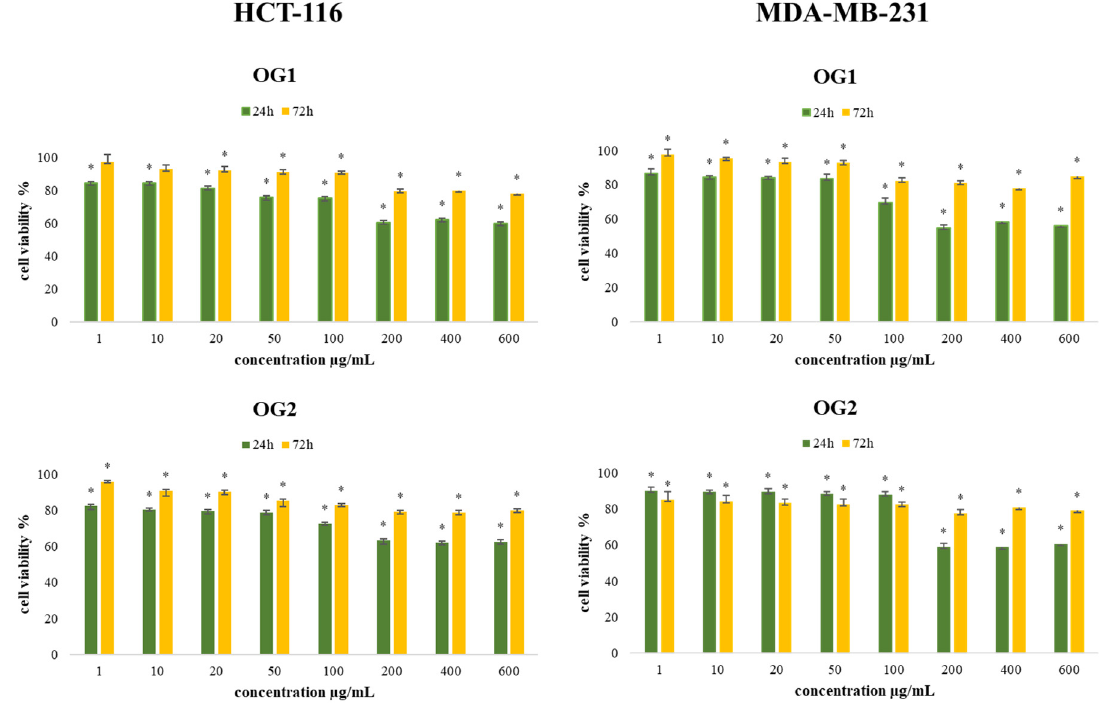
Figure 2. Effects of eight concentrations of essential oils (OG1 and OG2) on HCT-116 and MDA-MB-231 cells viability after 24 h and 72 h of treatment. Results are presented as the mean of three independent experiments ± standard error; * p < 0.05 relative to control.